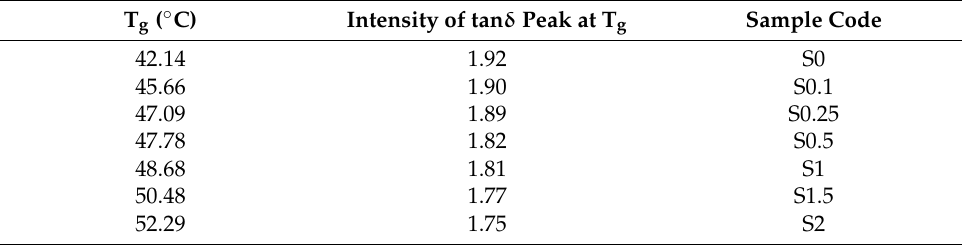
at 5% of weight loss; T 50 : Temperature at 50% of weight loss. Table 4. Variation in T g (Measured from the Peak of the tan δ